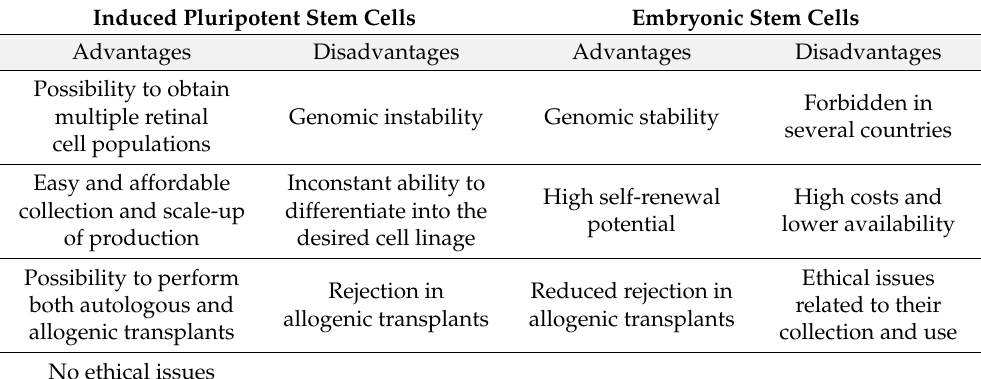
Table 2. Advantages and disadvantages of IPSCs and